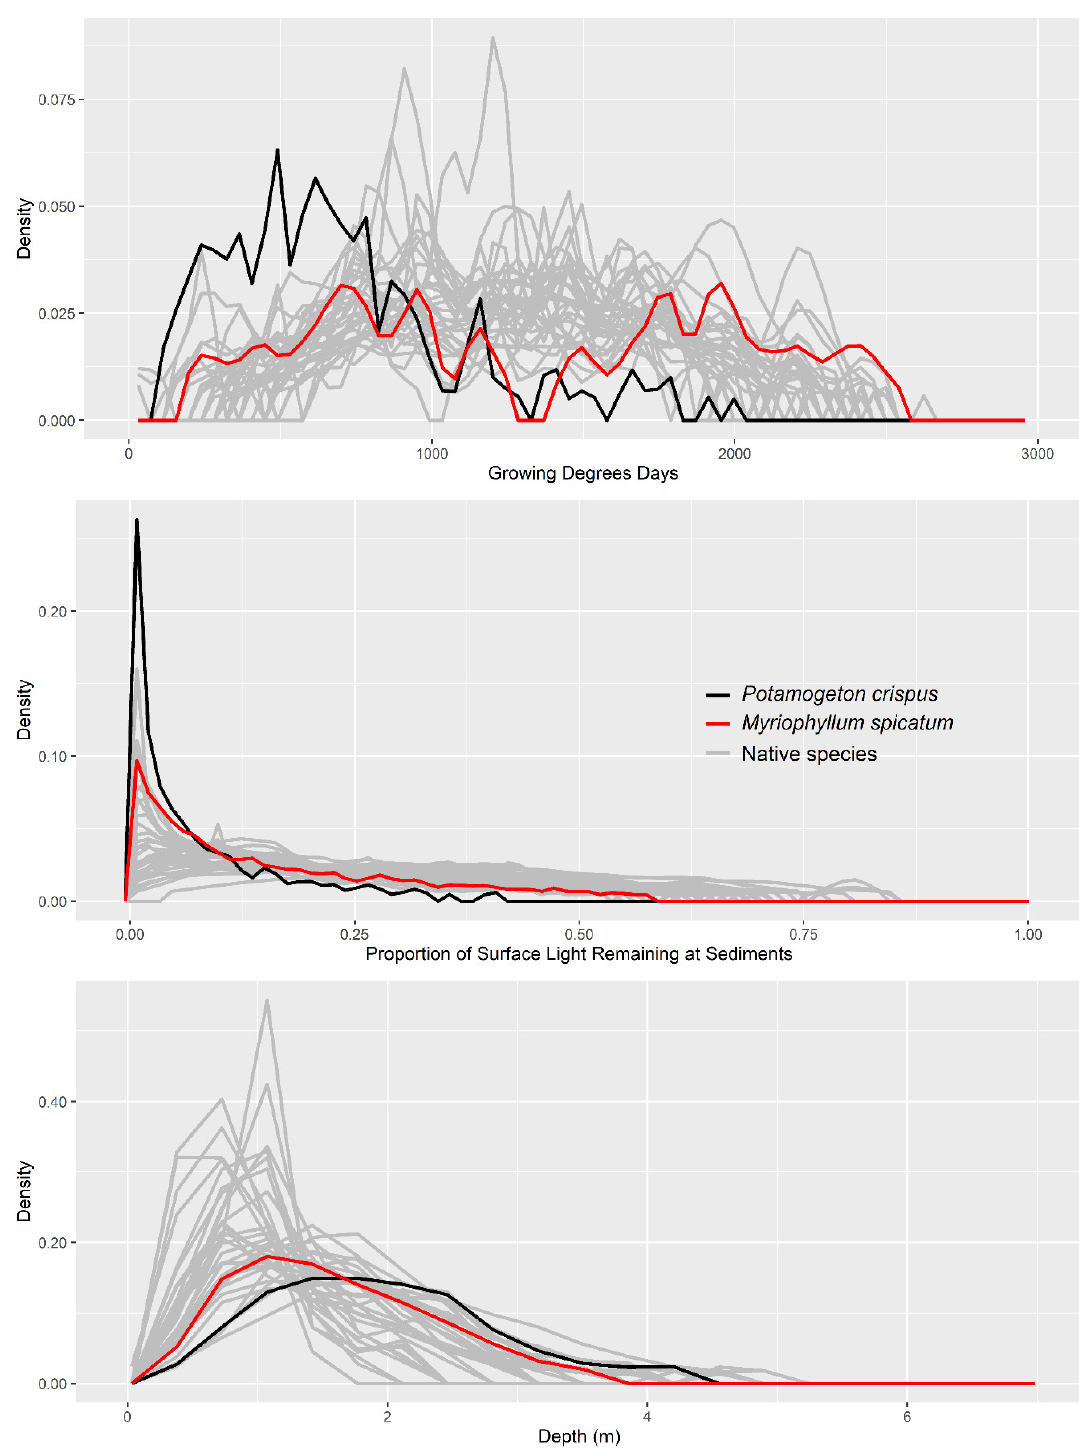
Figure 4. Abundance-based niches for 32 native macrophyte species and two invasive species ( Potamogeton crispus and Myriophyllum spicatum ). Niche models are probability density functions fit by kernel density estimation such that each species’ niche integrates to 1.